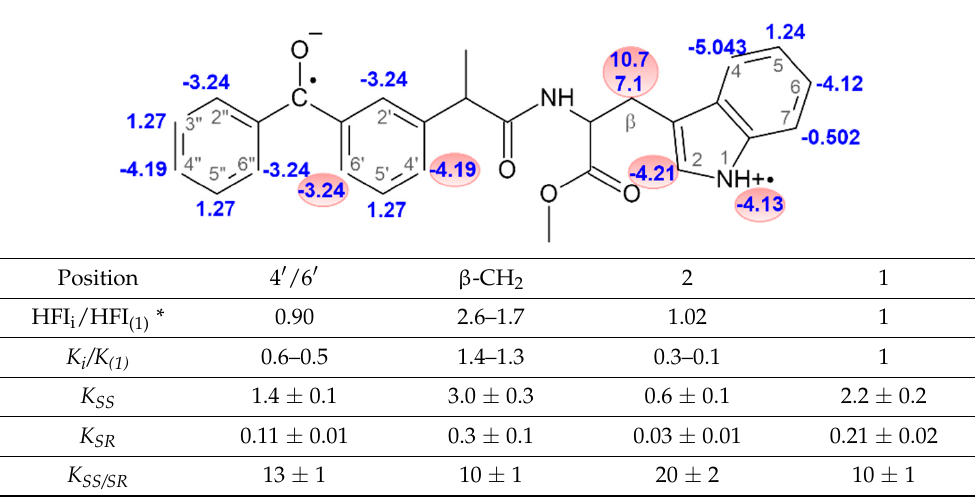
Table 4. The ratios of HFI constants and observed CIDNP coefficients ( K ) relative to 1-NH and the values of observed CIDNP coefficients for protons of dyad IV diastereomers in CD 3 CN.